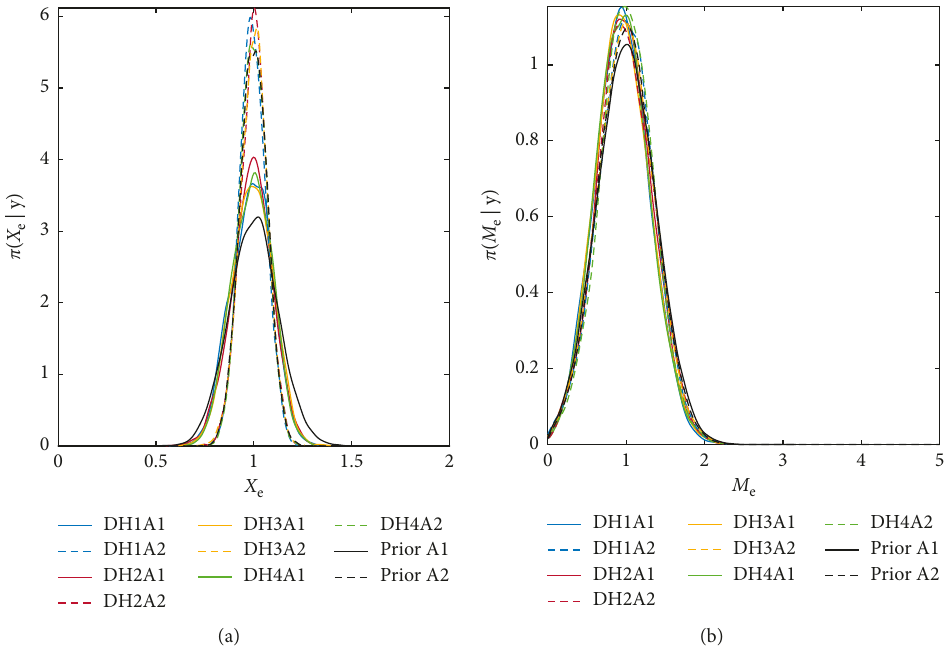
Figure 7: Anomaly scenarios A1 and A2. Prior covariance matrix with λ